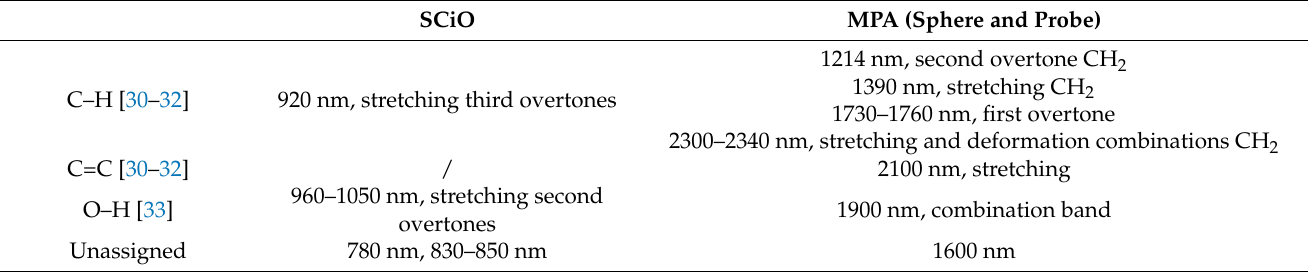
Table 2. Interpretation of spectroscopic signals related to the fatty acids, with literature